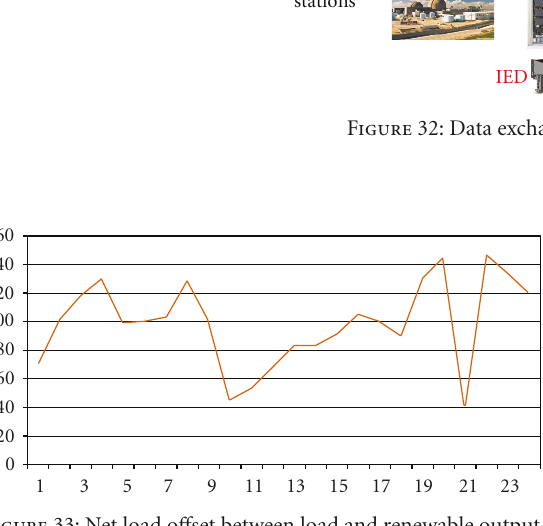
of March in 2009 [10]. The average price for the month is